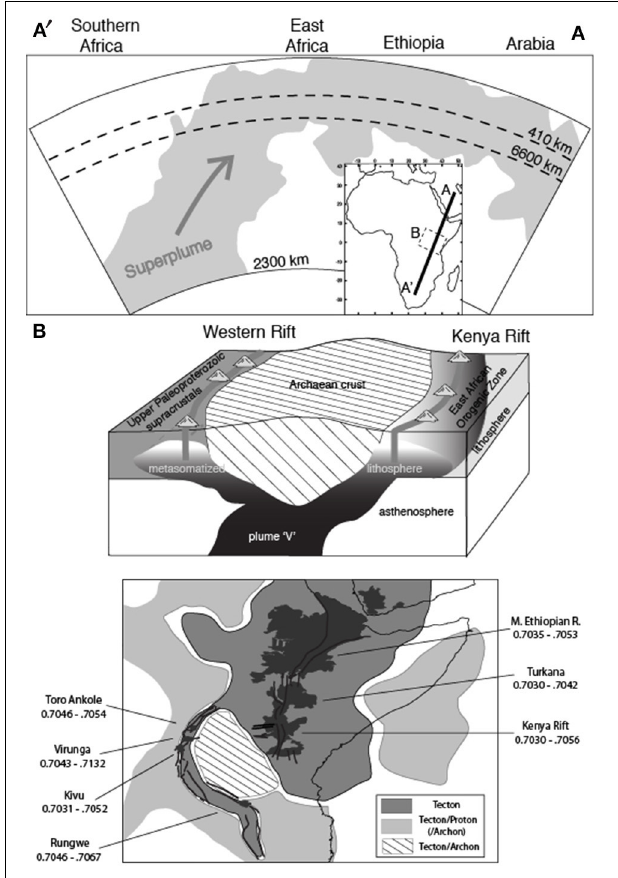
FIGURE 9 | Top panel —cross-section through the African and Arabian mantle (see inset for location of line A–A (cid:2) ). The gray area labeled Superplume is modified from the P-wave tomography model of Hansen et al. (2012). Dash lines mark the 410 and 660km discontinuities. This cartoon shows that the superplume comes from the core-mantle boundary, in one of the two lowest seismic velocity zones in the lower mantle (Castillo, 1988). Middle panel —schematic block diagram for the ∼ middle portion of the EARS (see inset for location of block B ). Some of the symbols are as in Figure 1 . The three major sources of the compositional spectrum of the EARS are (1) mantle plume V, (2) East African Orogenic Zone and (3) Upper Paleoproterozoic supcrustals ( + Archaean) lithosphere (mantle and crust). The metasomatized lithospheric mantle is the fourth, ∼ ubiquitous source. The superplume apparently has been supplying carbonatitic or plume material to the lithosphere beneath east Africa for